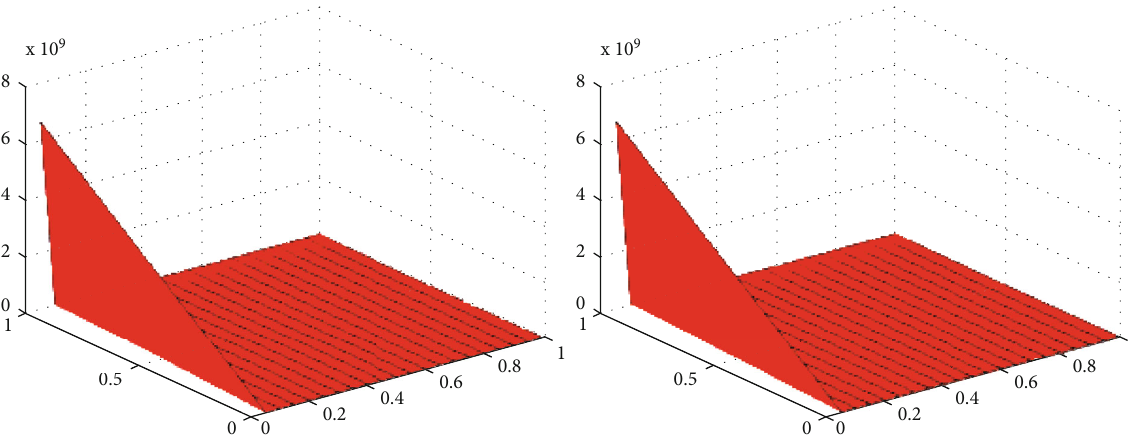
Figure 3: Graph of exact and analytical results of Problem 2.